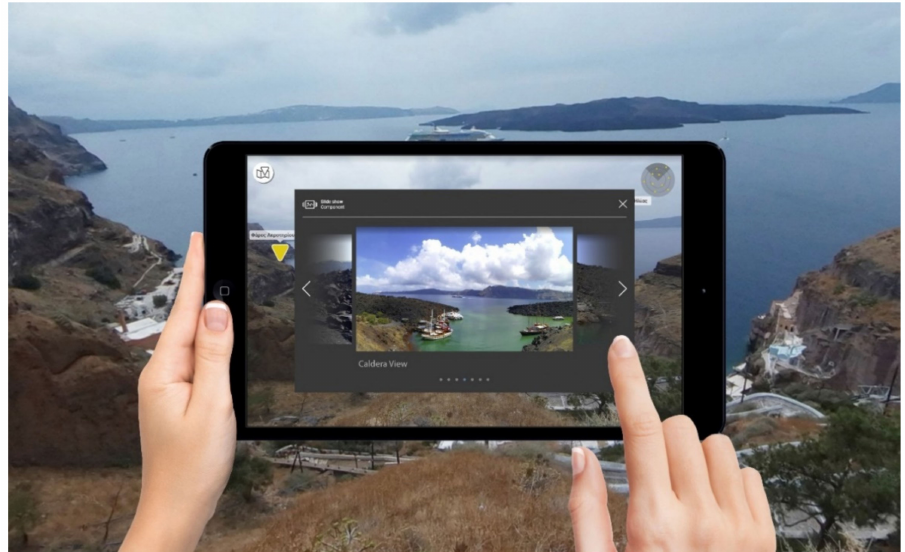
Figure 5. Multimedia selection in augmented reality (AR) environment—Image Viewer Component showing di ff erent views (photos) of Santorini island.